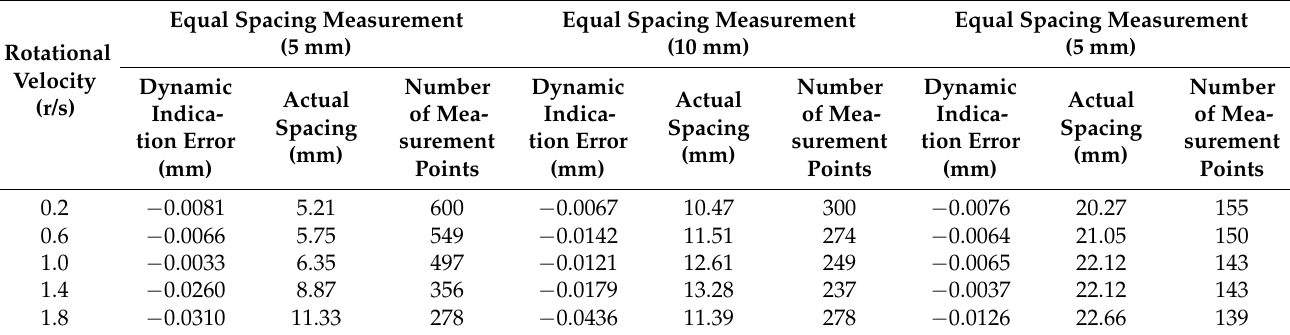
Table 4. Dynamic performance of laser tracker at evenly spaced and different speeds (D = 3 m).